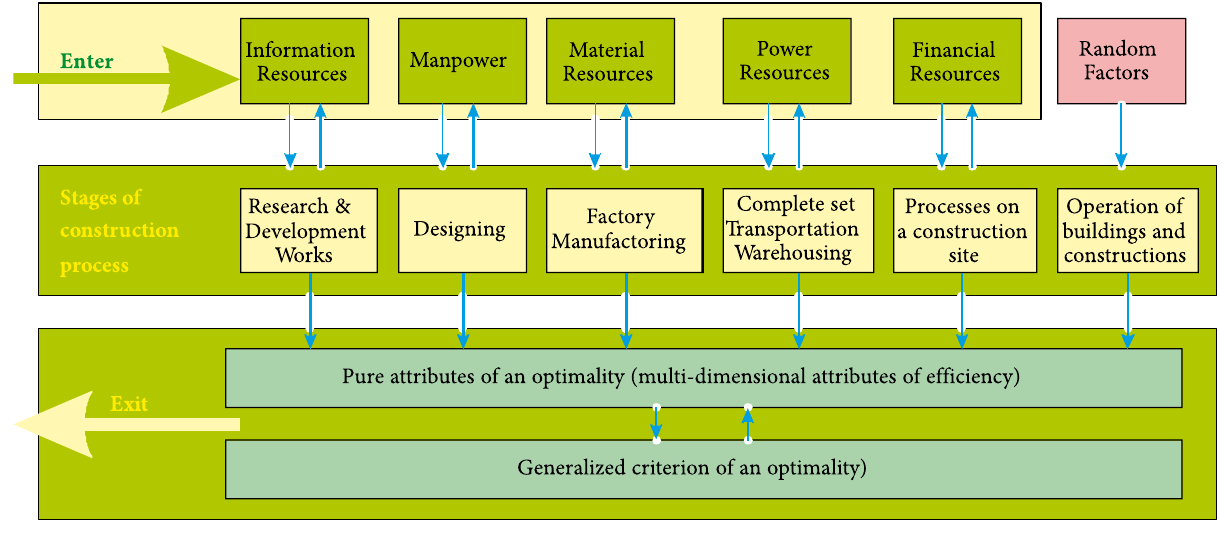
Fig. 4 . Cybernetic system of